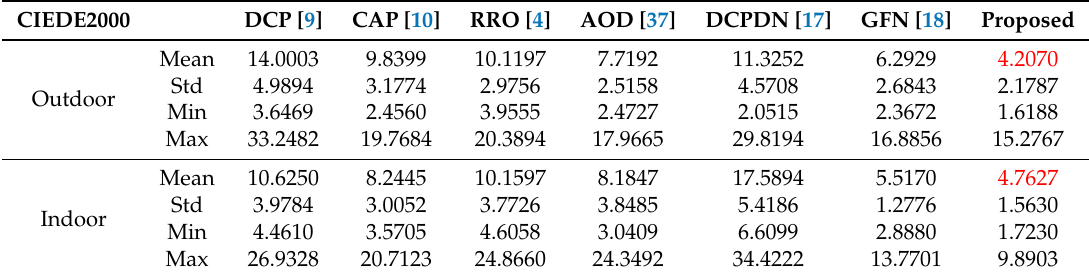
Table 5. Comparative CIEDE2000 results of dehazing methods on SOTS. Best score is marked in red. CIEDE2000